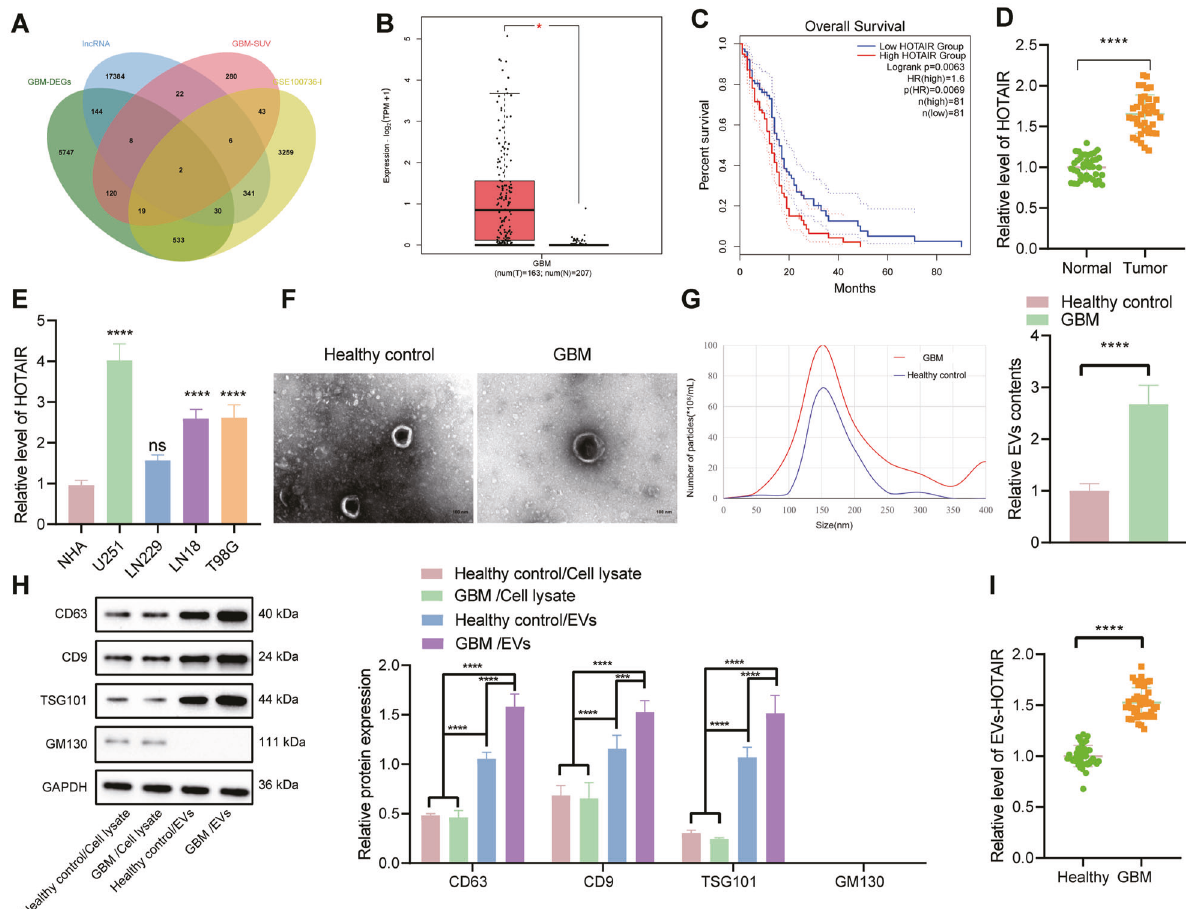
Fig. 1 HOTAIR is upregulated in clinical tissues, cells, and serum-EVs of GBM. A Venn diagram of upregulated genes from the GEPIA database, the top 500 survival-related genes, upregulated lncRNAs from the GSE100736 data set, and human lncRNA names from the GENCODE database. B A box plot of HOTAIR expression in TCGA-GBM. The red box on the left indicates GBM samples, and the gray box on the right indicates normal samples. * p < 0.05. C Correlation analysis of HOTAIR expression with the overall survival of GBM patients in TCGA-GBM. D RT-qPCR detection of HOTAIR expression in normal brain tissues ( n = 40) and GBM tissues ( n = 40). **** p < 0.0001. E RT-qPCR detection of HOTAIR expression in GBM cell lines and human primary astrocytes NHA. **** p < 0.0001, ns, not signi fi cant, compared with NHA cells. F Morphology of serum-EVs of GBM patients ( n = 40) and healthy controls ( n = 40) observed under a TEM. G Graph (left panel) and quanti fi cation (right panel) of NTA results of the size distribution and relative concentration of serum-EVs of GBM patients ( n = 40) and healthy controls ( n = 40), **** p < 0.0001. H Western blot analysis of CD63, CD9, TSG101, and GM130 proteins in the serum-EVs of GBM patients ( n = 40) and healthy controls ( n = 40). I RT-qPCR detection of HOTAIR expression in serum-EVs of GBM patients ( n = 40) and healthy controls ( n = 40). **** p < 0.0001. Each experiment was repeated three times